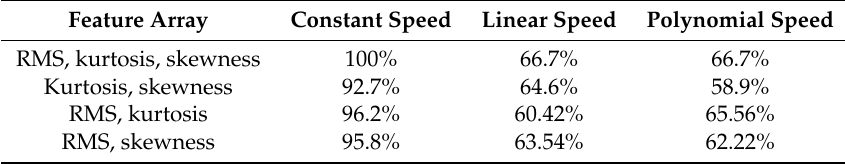
Table 5. Accuracy of the SVM with different feature